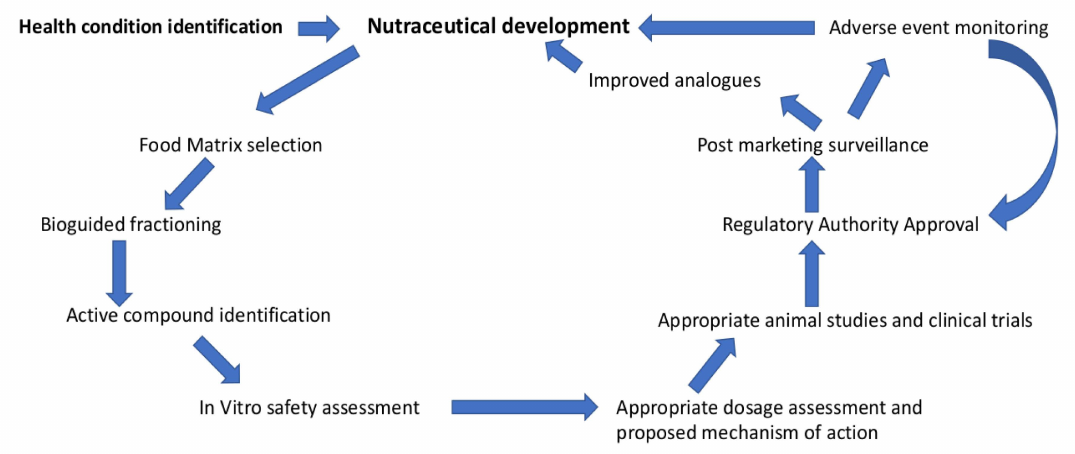
Figure 1. Proposed protocol for development of new